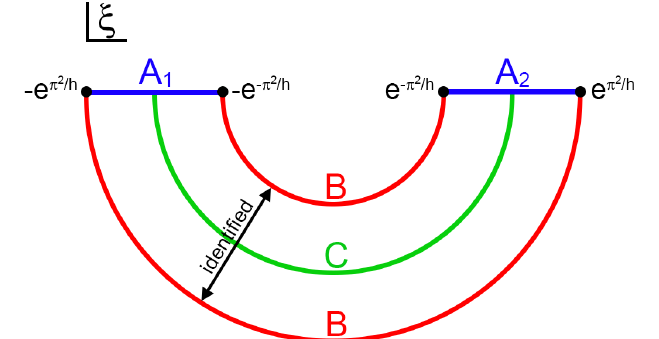
Figure 25 . In the thermal AdS 3 phase, the boundary finite cylinder in ζ coordinates is mapped to a boundary half annulus in Poincaré coordinates. The inner and outer radii of the annulus are